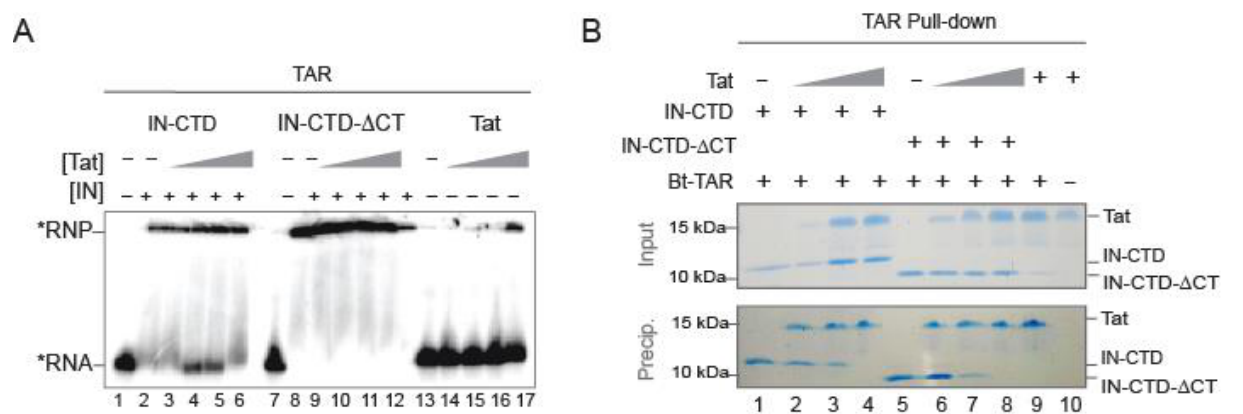
Figure 4. Tat competes against IN-CTD for TAR binding. ( A ) EMSA assay showing a dose-dependent competition assay of Tat on IN-CTD/TAR or IN-CTD- ∆ CT/TAR complexes. TAR (50 nM), labelled with 32P (black star), was incubated with 16 fold molar excess of IN-CTD (800 nM, lanes 2–6) or IN-CTD- ∆ CT (lanes 8–12) with or without increasing concentration of Tat (25, 50, 100, 200 nM). Tat vs IN-CTD is shown in lanes 3–6 and IN-CTD- ∆ CT in lanes 9–12. Control binding of Tat on TAR was also performed using Tat alone (lanes 13 – 17). ( B ) Protein co- precipitation with 3′ end-biotinylated TAR (Bt-TAR). IN-CTD (lanes 1–4) or IN-CTD- ∆ CT (lanes 5 and 8) were mixed with increasing amount of Tat (1, 2, 3 µg/sample; lanes 2, 3, 4 and 6, 7, 8) and incubated in a buffer containing 200 mM NaCl before co -precipitation. Tat was incubated with Bt-TAR alone (lane 9) or TAR-free beads as a control for unspecific binding (lane 10). Input (20% of total) and pull-down fractions were analyzed by 15% SDS-PAGE followed by Coomassie blue staining.